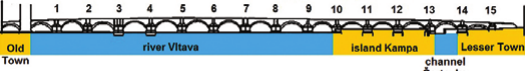
Fig. 2. System of bridge pillars